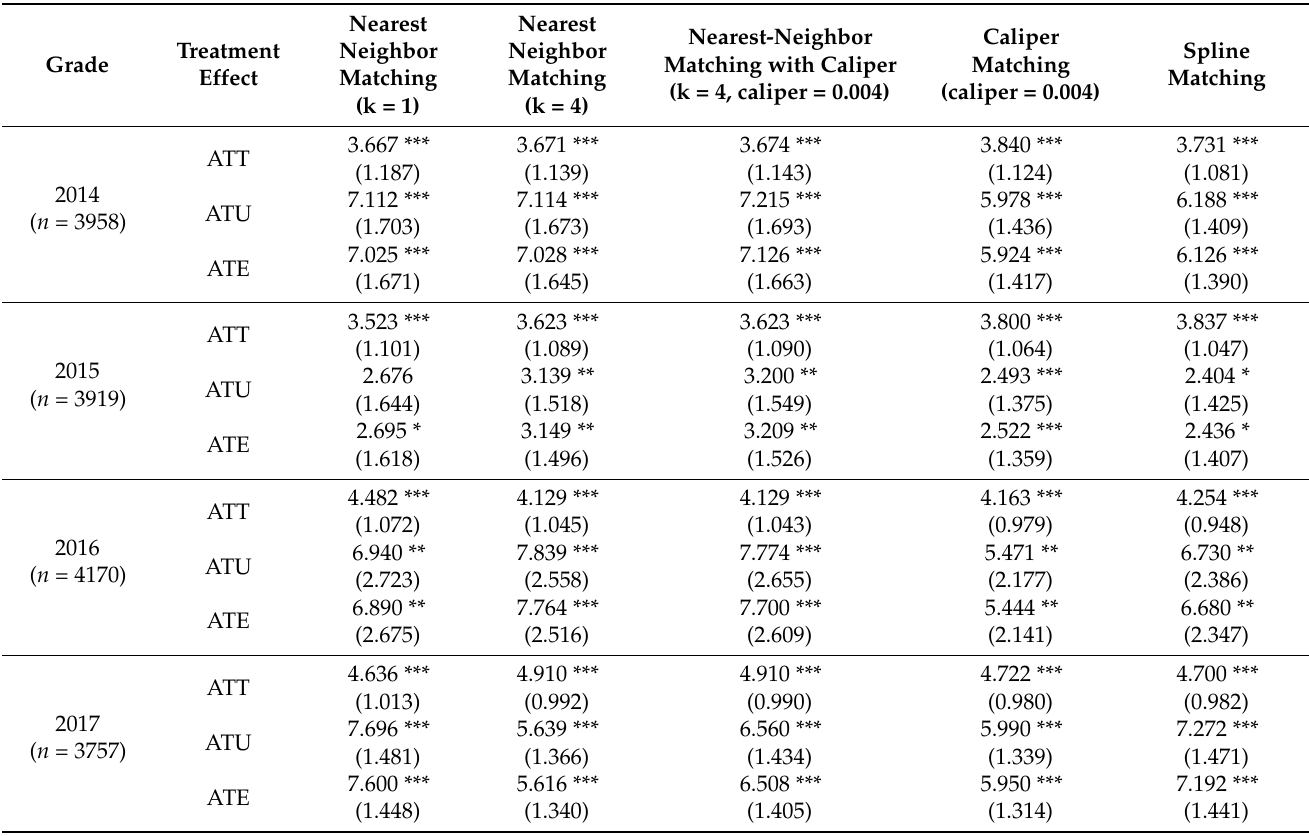
Table 4. Treatment effects of left-behind experience in each grade.